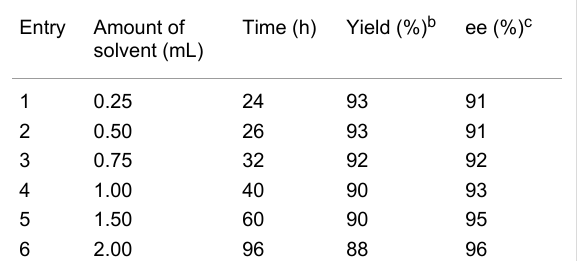
Table 1: Solvent screening the Michael addition of acetone ( 2a ) to isatylidenemalononitrile ( 3a ) catalyzed by 1a TCA. a Entry